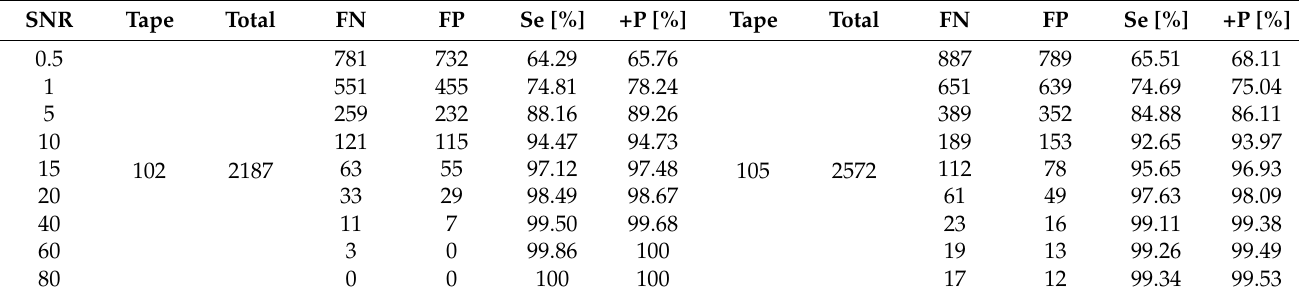
Table 3. R-peak detection performance of the proposed method for SNR